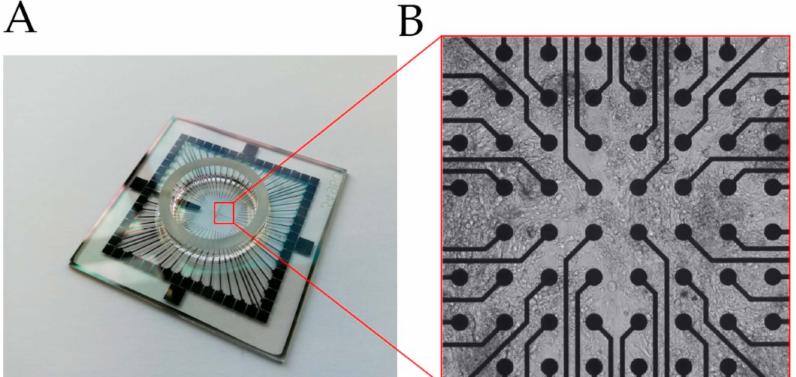
Figure 1. ( A ) Glass multi- / micro-electrode array (MEA) chip used to detect field potential (FP) of cells. ( B ) Cells seeded on an MEA surface, grown on top of the electrodes (black dots), Video